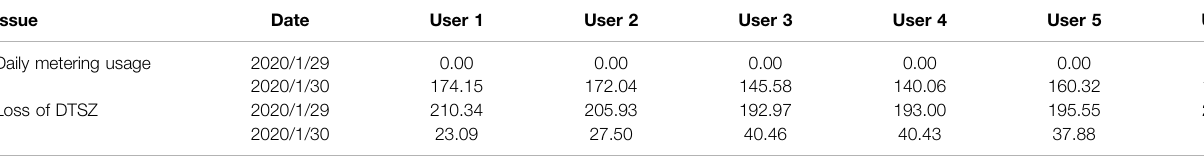
TABLE 4 | Daily electricity usage of each anomaly user and loss of DTSZ.